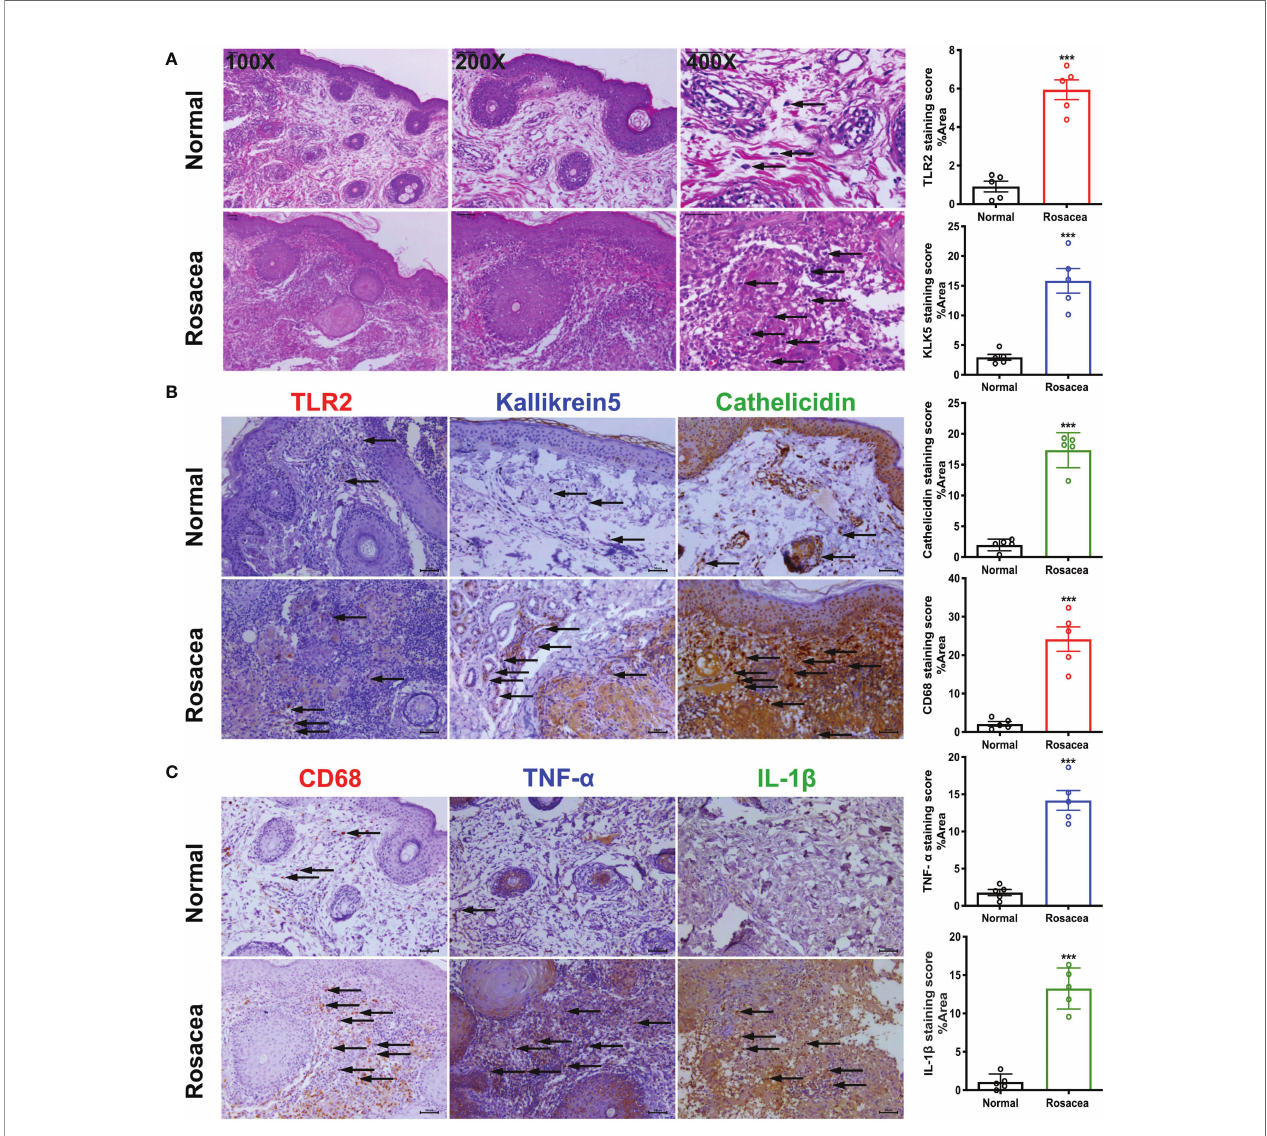
FIGURE 1 | In fl ammatory cells especially macrophages are abundant in rosacea skin, together with cathelicidin. The skin lesions (n = 5) of individuals with rosacea were biopsied and embedded into wax blocks. (A) Profound accumulation of in fl ammatory cells can be observed in the skin samples stained by HE. The pictures were taken under ×100, ×200, and ×400 magni fi cation. (B) TLR2, KLK5, and cathelicidin are abundant in lesional skin of individuals with rosacea as detected by immunochemical staining; the pictures were taken under ×200 magni fi cation. (C) Macrophages in lesional skin of individuals with rosacea as examined by immunohistochemistry with an antibody against CD68, and in fl ammatory reactions determined by staining with antibodies against TNF- a and IL-1 b . The pictures were taken under ×200 magni fi cation; ***P <0.001 (n =